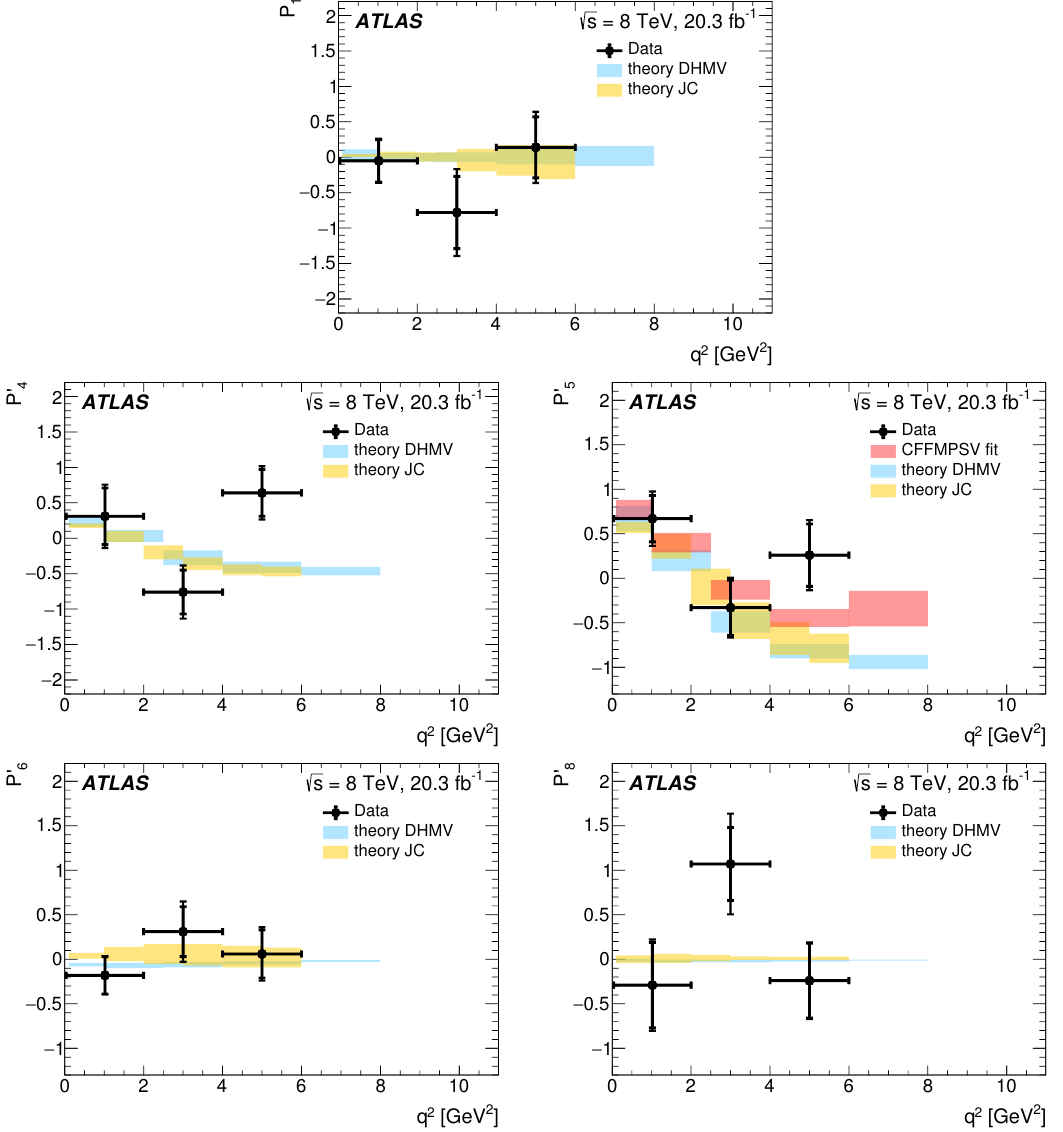
Figure 11 . The measured values of P theoretical calculations discussed in the text (section 8). Statistical and total uncertainties are shown for the data, i.e. the inner mark indicates the statistical uncertainty and the total error bar the total